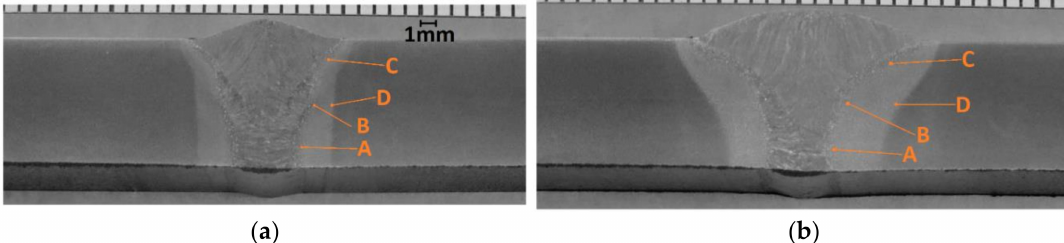
Figure 13. Locations of the SEM images in the cross section of weld specimens: ( a ) low heat input, t 8/5 = 5 s; ( b ) high heat input, t 8/5 = 20 s.